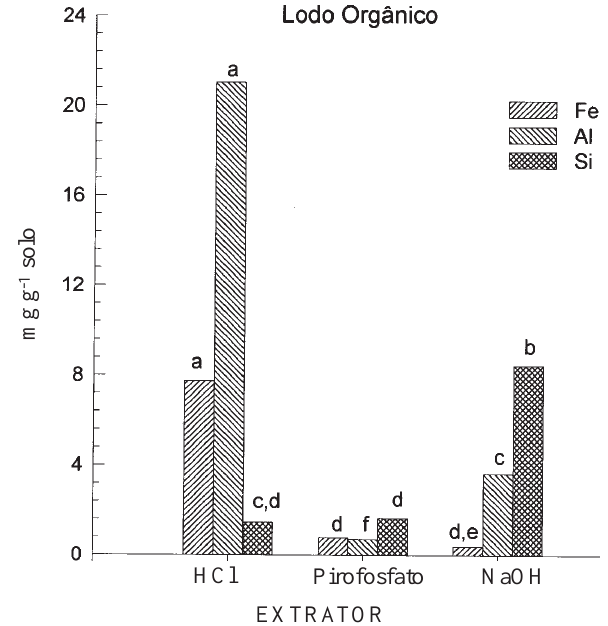
Figura 3. Teores de Fe, Al e Si, determinados nos extratos de HCl 0,5 mol L -1 , pirofosfato 0,15 mol L -1 (pH 7) e NaOH 0,5 mol L -1 do método 2, no LO. Letras minúsculas diferenciam médias, pelo teste de Duncan a 5%, para cada elemento em todas as três amostras das figuras 1, 2 e